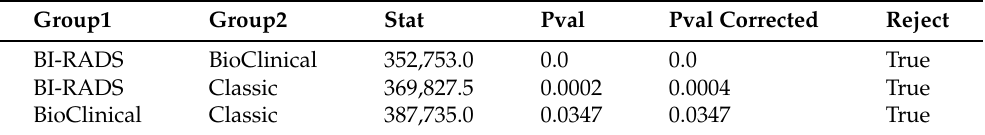
Table A2. Bonferonni-corrected Mann–Whitney U test results for section segmentation without auxiliary data.